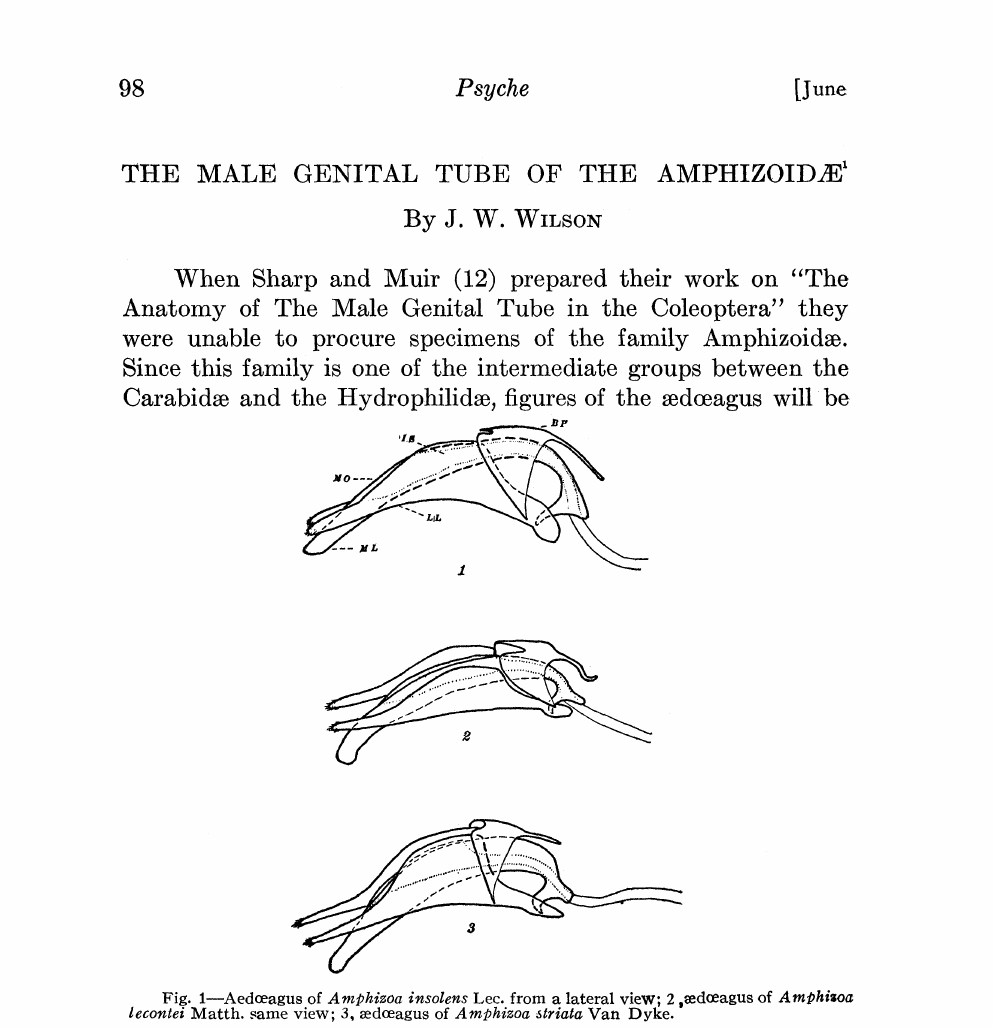
Fig. 1--Aedeagus of Amphizoa insolens Lec. from a lateral view; .mdceagus of Amphisoa lecontei Matth. same view; 3, mdceagus of Amphizoa .triata Van